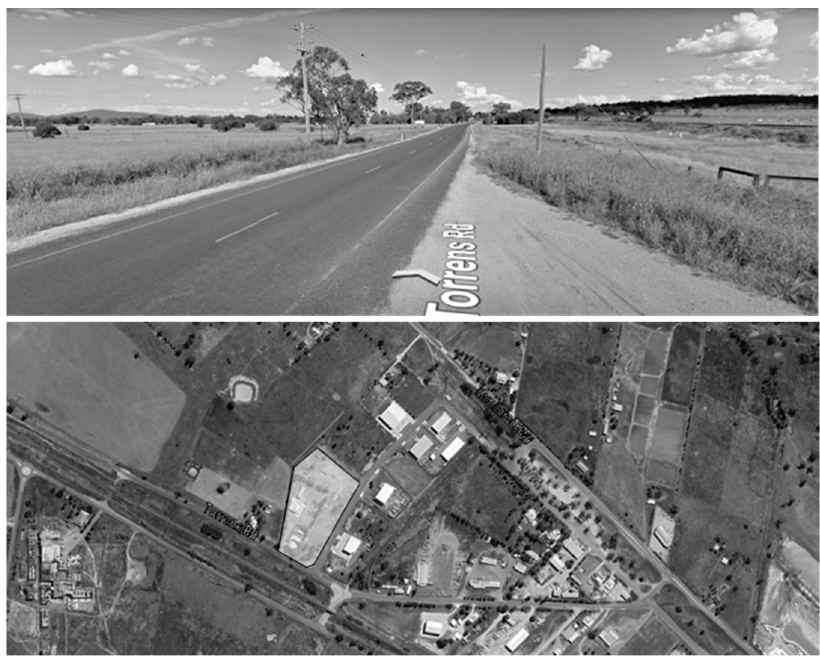
Figure 2. The location of the proposed C&D waste management facility in Gunnedah. Source: Google Maps [48].